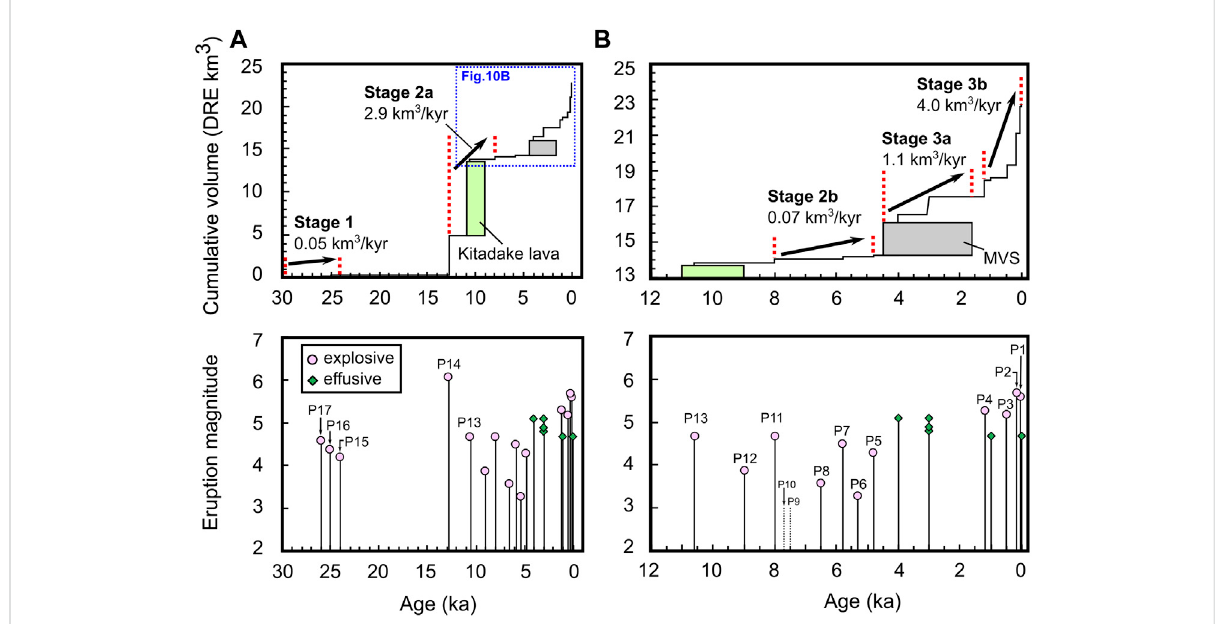
FIGURE 10 Temporal variations of the magma discharge rate of Sakurajima volcano. The upper panels of Figures 10A,B show a diagram of cumulative discharged magma volume with time. Squares describe the Kitadake lava (green) and the Minamidake Volcanic Sand (MVS; gray) with estimated cumulative eruption durations and volumes. The lower panels show the eruption magnitude of each eruption (see Table 4). (A) shows the entire activity of Sakurajima, and (B) shows the activities within the last 12,000 years. Note that the vertical axis values of the upper image in Figures 10A,B are not the